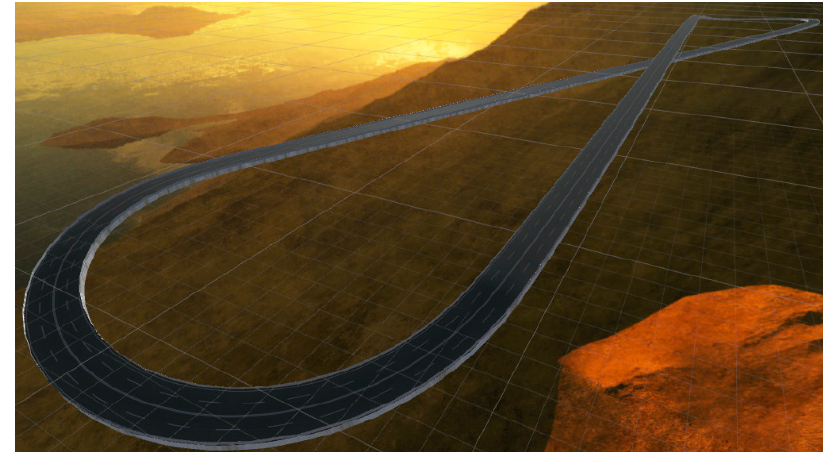
Figure 5. Training track.